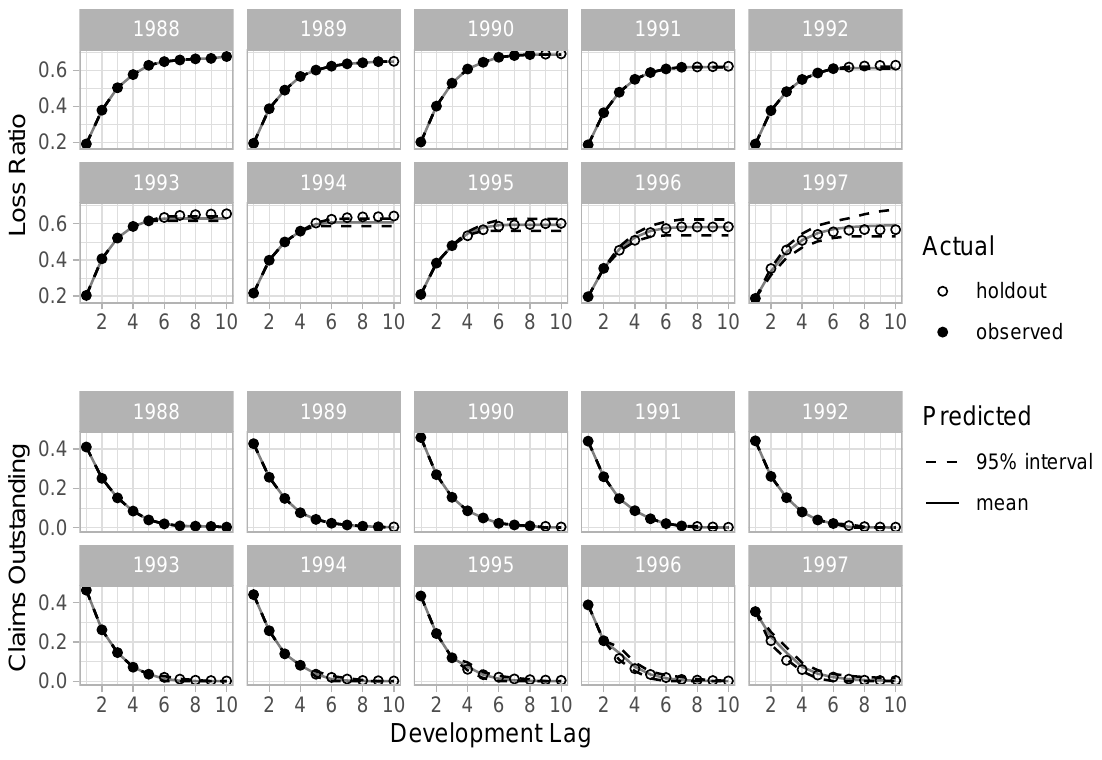
Figure 4. Development by accident year for Company 1767, commercial